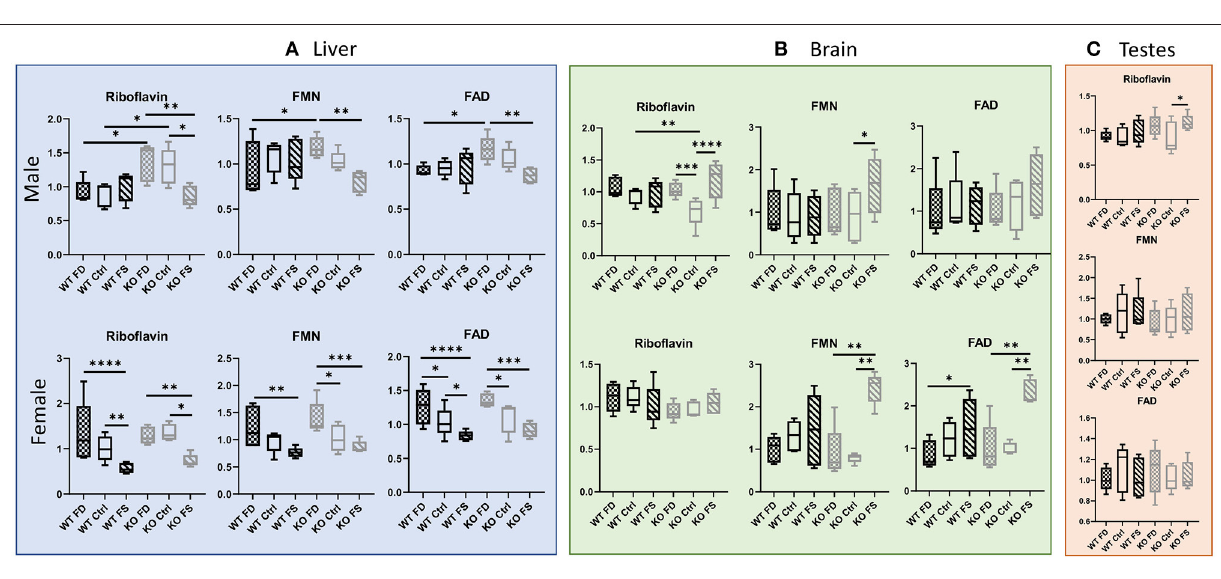
FIGURE 4 | High dietary FA decreased liver concentrations of riboflavin, FMN and FAD in females of both genotypes and KO males, but not in WT male livers (A) , brains (B) , or testes (C) . Female brains showed no difference for riboflavin in both genotypes (B) . Trend for increased FMN and FAD on FS diet was found for KO brains in both sexes (B) . Data show minimum and maximum, with bar at median value, n = 5. Checked bars, FD diet; solid bars, Ctrl diet; striped bars, FS diet. WT is shown in black, and KO is shown in gray. * p < 0.05; ** p < 0.01; *** p < 0.001; **** p < 0.0001; determined by ANOVA